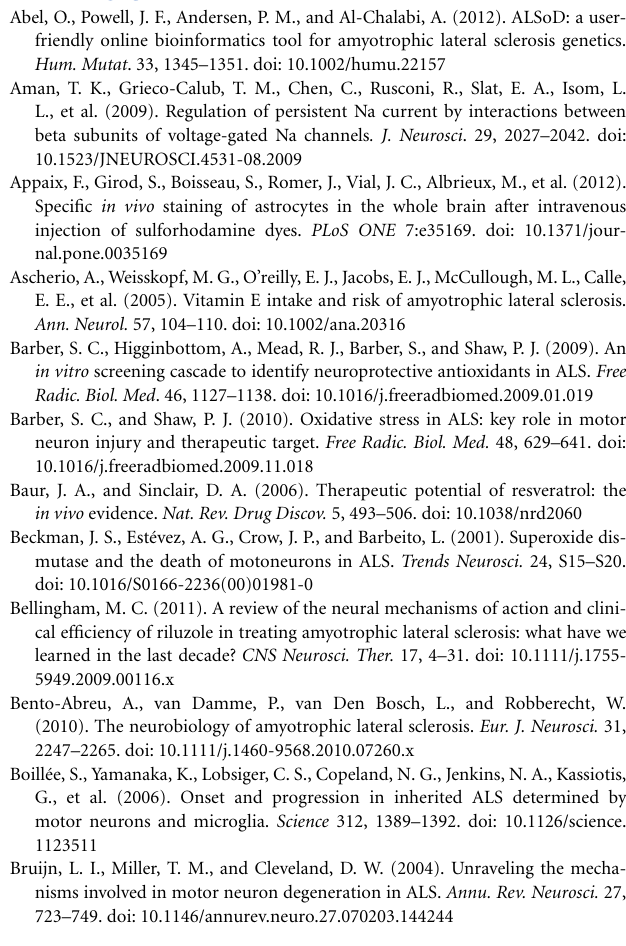
Figure 3 . Values represent mean ± s.e.m. from at least 3 independent experiments performed in duplicate, analyzed by t -test vs.